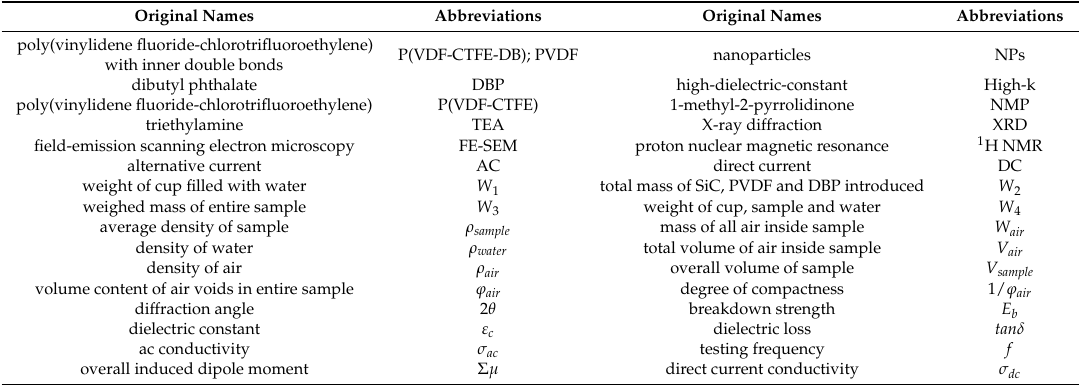
Table 1. Abbreviations for all the long names to increase the